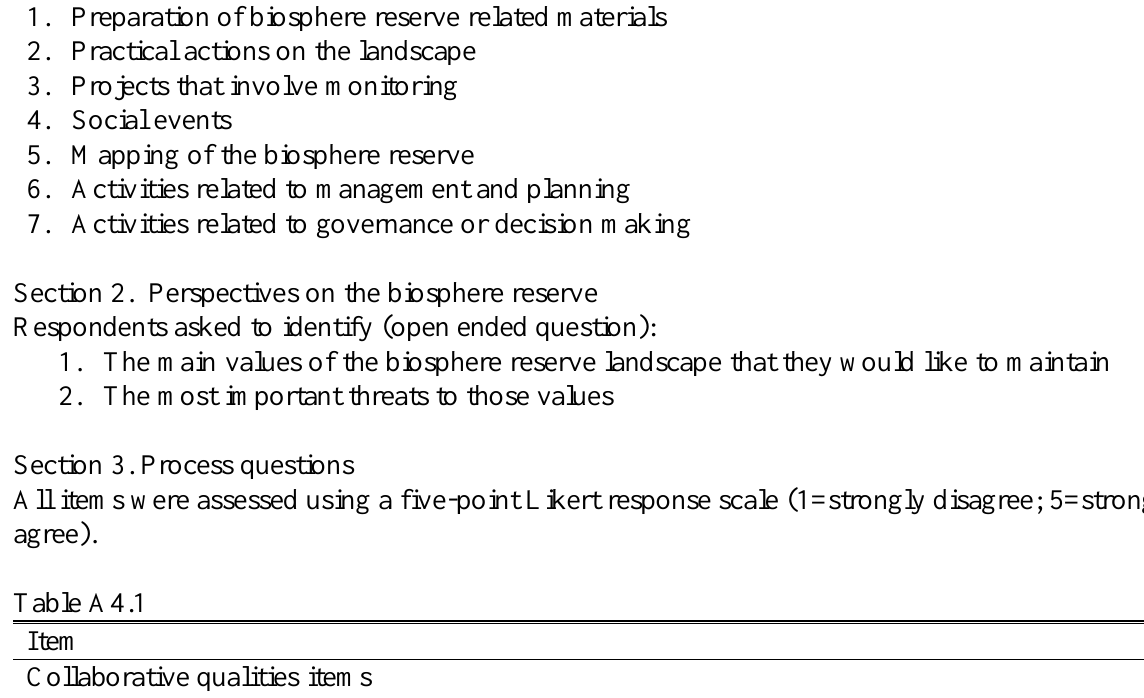
Pluralism and linkages Open communication,